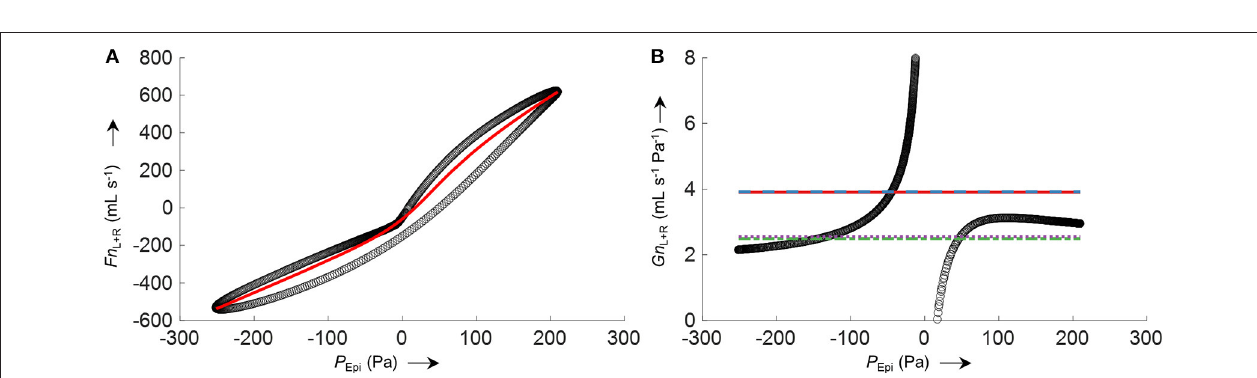
FIGURE 8 | Example for the calculation of total nasal conductance ( Gn L R ) of a representative 2-min segment from averaged nasal airflow ( Fn L + pressure ( P Epi ) by different conductance algorithms. (A) Non-linear logistic curve fit (8-PL model, red line) to the averaged left and right nasal airflow Fn L (black circles) where Fn’ L against P Epi (black circles). (B) Fn L + R ′ P R corresponds to left and right airflow derived by the non-linear curve fit shown in (A) ; average total Epi + nasal conductance Gn L R obtained by different algorithms are depicted as straight horizontal lines: mean (cid:18) + Fn L P Epi,max Fn L ( P Epi,min ) dFn L + R (cid:0) + R + R ′ dP Epi (cid:19) (dotted purple). The conductance functions show a discontinuity at zero pressure because of a P Epi,max P Epi,min (dash-dotted green), mean (cid:18) (cid:1) − − slight hysteresis or dysynchrony of pressure and flow